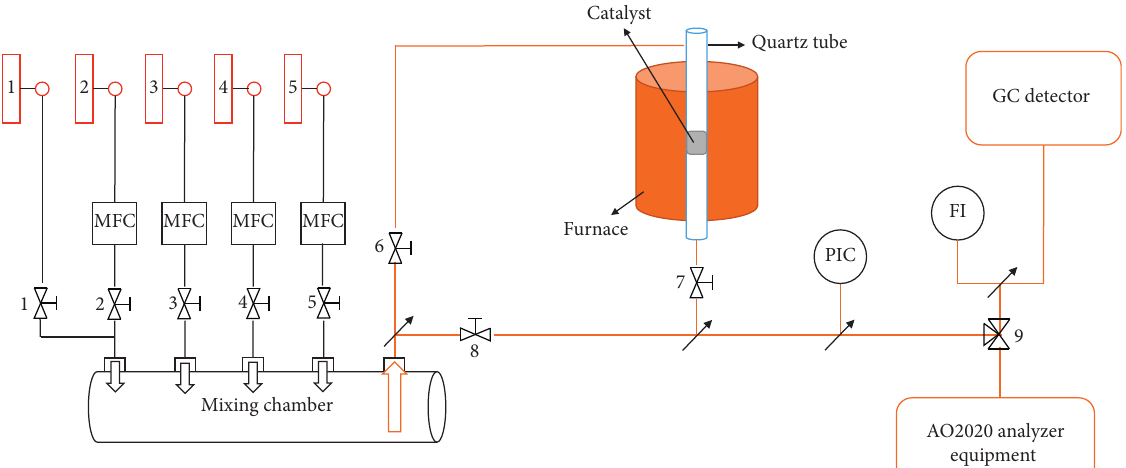
Figure 1: Schematic diagram of the experimental apparatus for activity test.